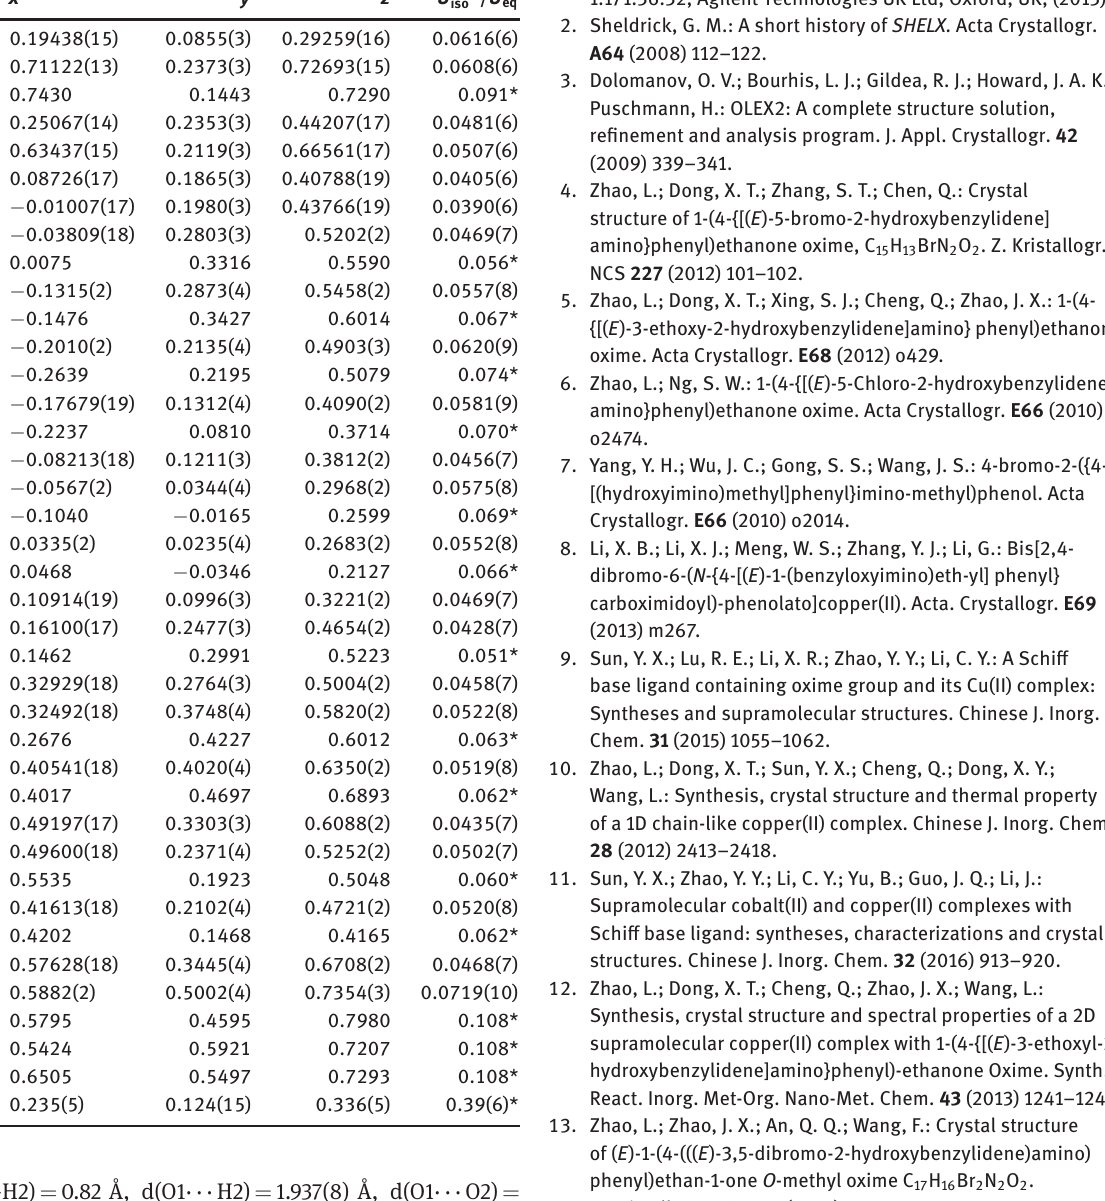
Table 2: Fractional atomic coordinates and isotropic or equivalent isotropic displacement parameters (Å 2